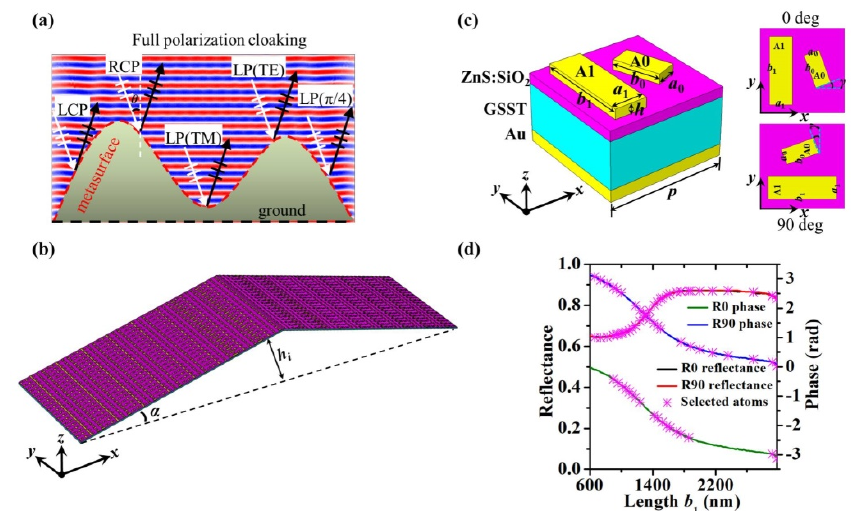
Figure 1. Principle diagram and design scheme of the polarization-immune metasurface carpet cloak. ( a ) Principle diagram of the polarization-immune metasurface carpet cloak wrapping on metallic bumps with arbitrary boundaries. It can work well upon all LP (TM), LP (TE), LP ( π /4), LCP and RCP incident beams. ( b ) As a proof, an ultrathin triangular metasurface carpet cloak is designed in which the tilt angle of the triangular bump is a = 15°, h i represents the vertical distance from the center point of the meta-atom to the flat plane. ( c ) Left: Schematic of the meta-atoms (0 degrees) of the proposed metasurface. Right: Top views of the meta-atoms arranged at 0 (top) and 90 (bottom) degrees. ( d ) Normalized reflectance and propagation phases of anisotropic Au nanoantenna pairs with length b 1 spanning from 600 to 2900 nm, while other parameters remain un- changed.